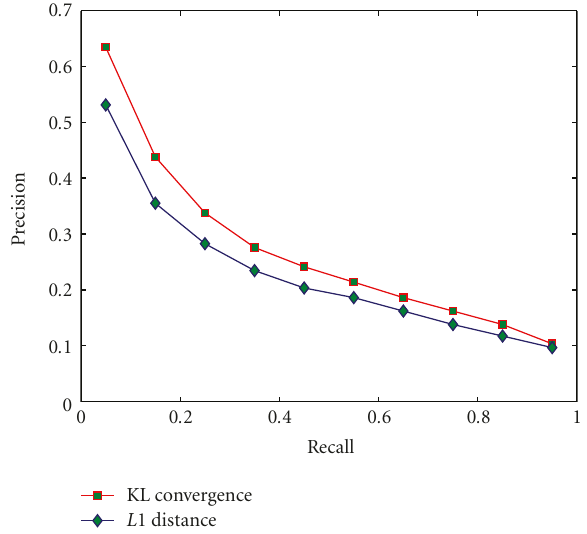
Figure 5: Precision-recall (PR) plots obtained with KL and L 1 dissimilarity measurement when doing